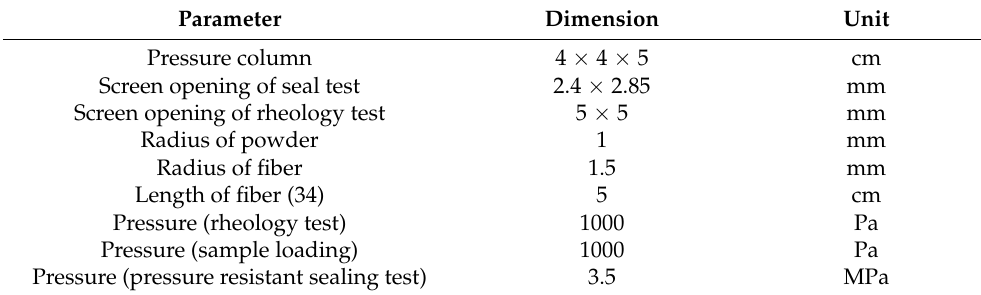
Figure 3. Snapshots of ( a ) the pressure column and sieve models, ( b ) powder model, ( c ) single fiber model, and ( d ) fiber model used in simulation. Table 1. Physical parameters of the models for the